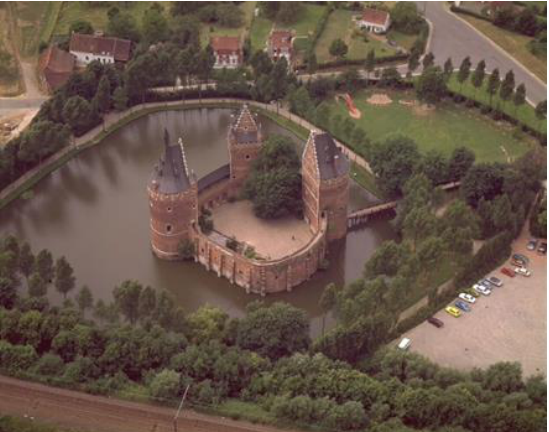
Figure 2. Castle as defined in archaeological heritage (Feudal castle of Beersel, copyright Flanders